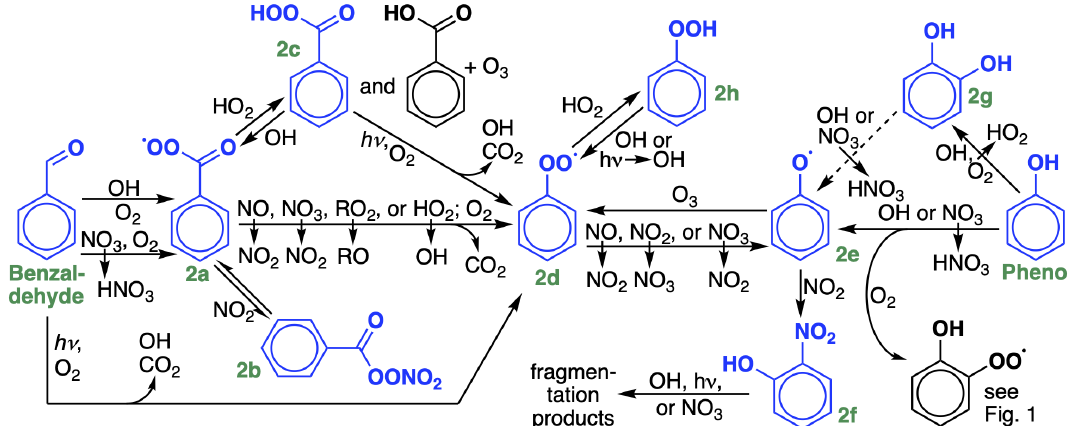
Figure 2. Oxidation chemistry of stable ring-retaining aldehydes and alcohols from benzene, toluene, and xylene. For simplicity, only benzaldehyde and phenol are shown; cresol chemistry is not shown but is similar to phenol. GC13 lumps tolualdehyde with benzaldehyde, xylenols with cresol, and methylcatechols with catechol. Species treated explicitly and uniquely in the GC13 mechanism are highlighted in blue. The reaction of catechols (Fig. 2g) with OH produces substituted phenoxy radicals, lumped here with the phenoxy radical (Fig.